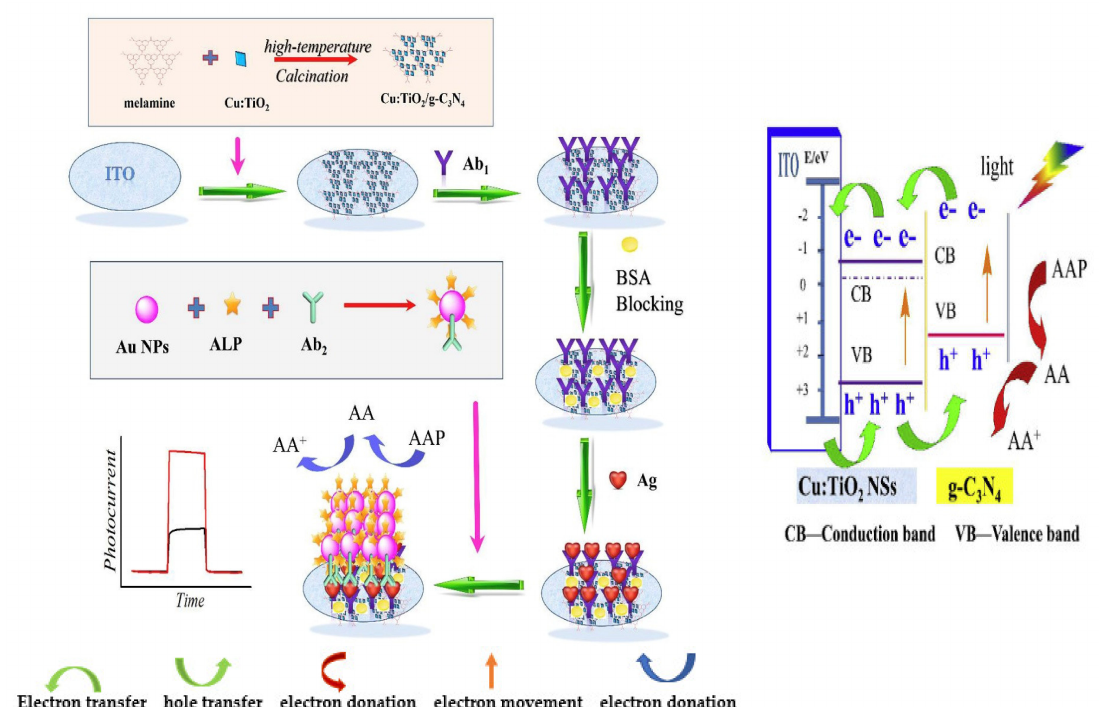
Figure 24. Schematic illustration and electron transfer mechanism of the PEC immunosensor. e: electron; h: hole: AA: ascorbic acid; AAP: ascorbic acid 2–phosphate; Ag: antigen; Ab1: pri- mary antibody; Ab2: Secondary antibody. Reprinted with permission from [28], published by Elsevier,